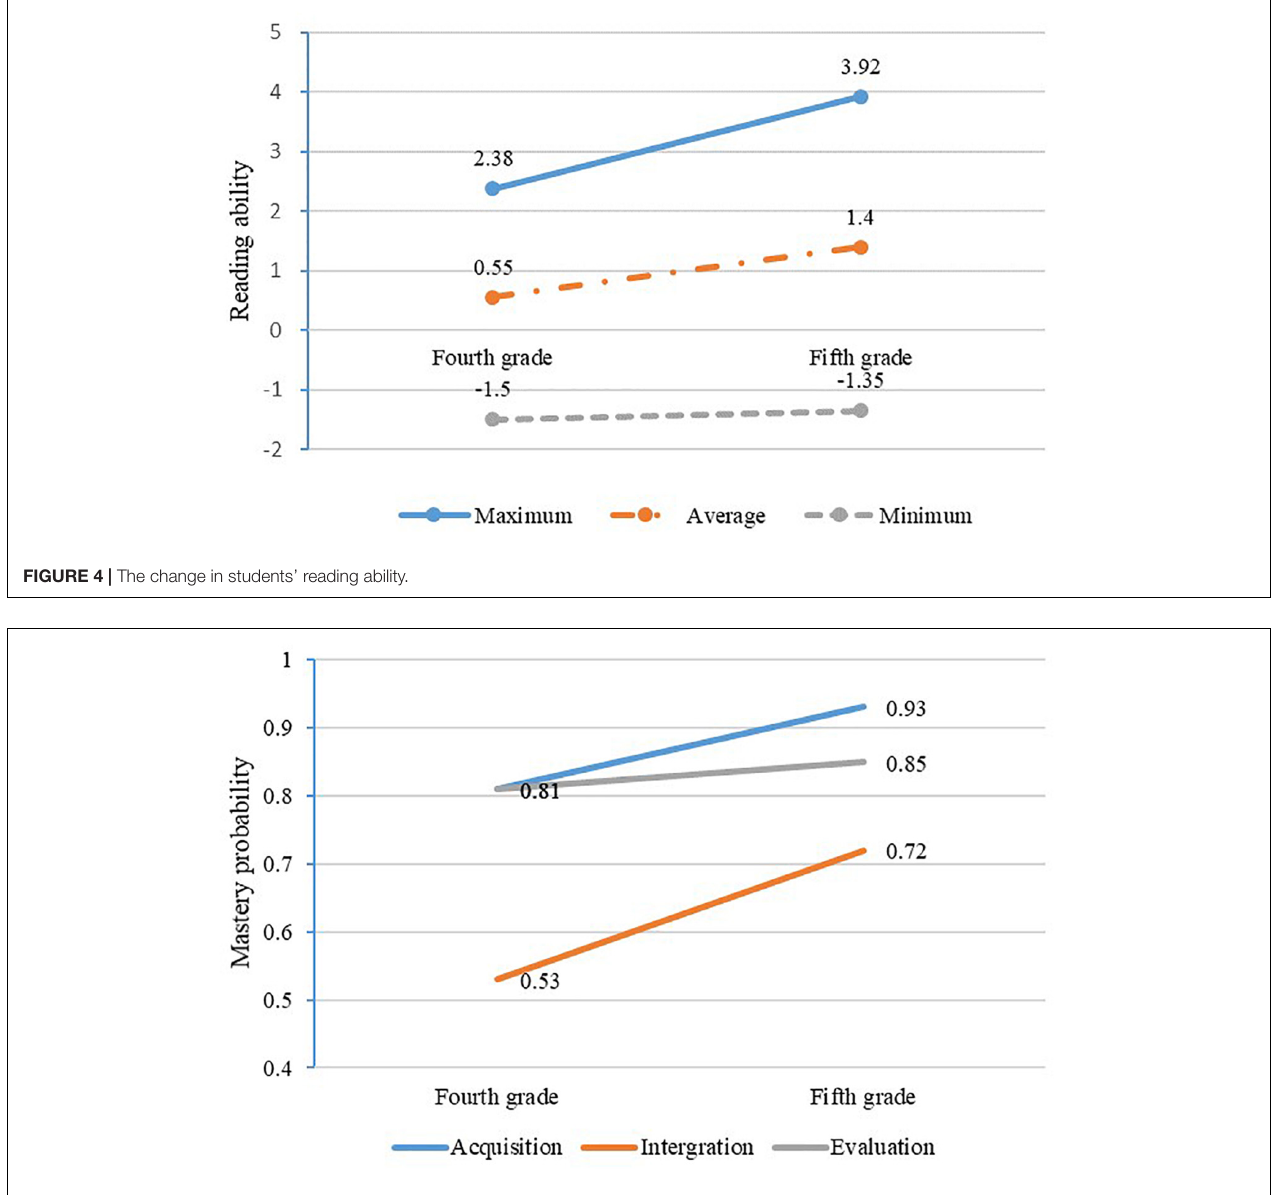
FIGURE 5 | The change of attribute mastery